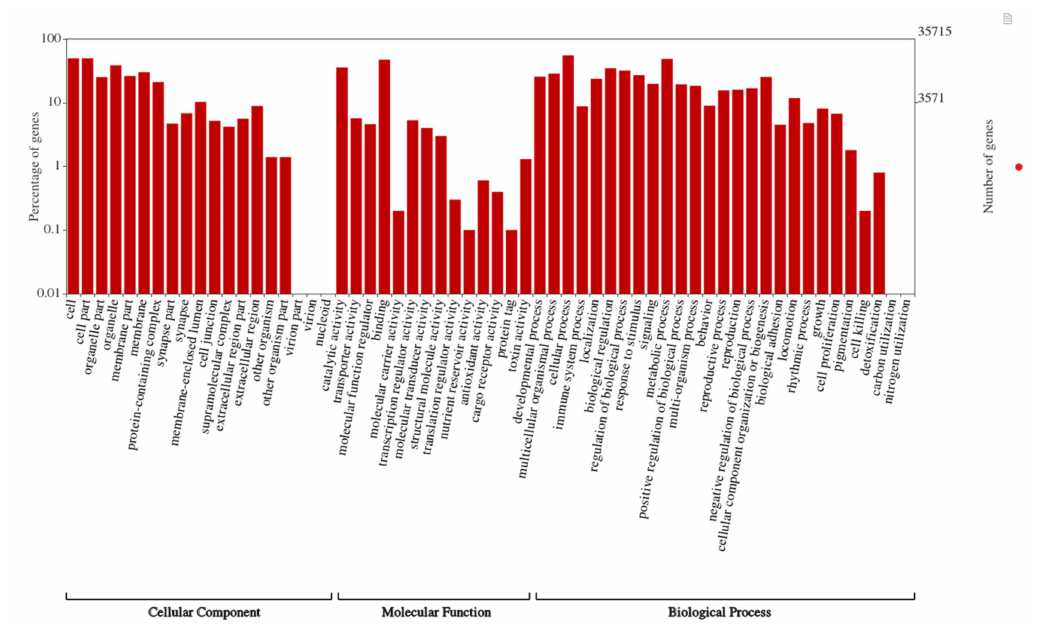
Figure 2. Gene ontology (GO) classification of the Psacothea hilaris transcriptome. The GO was summarized into three main categories: Biological process, Cellular component, Molecular function. X axis indicates number of unigenes, and y axis indicates the sub-categories of GO